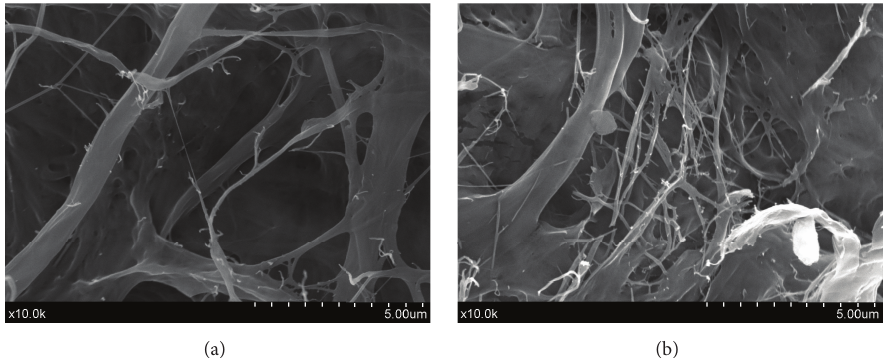
Figure 2: SEM micrographs of cellulose fibrils. (a) UMCF and (b) CMCF.